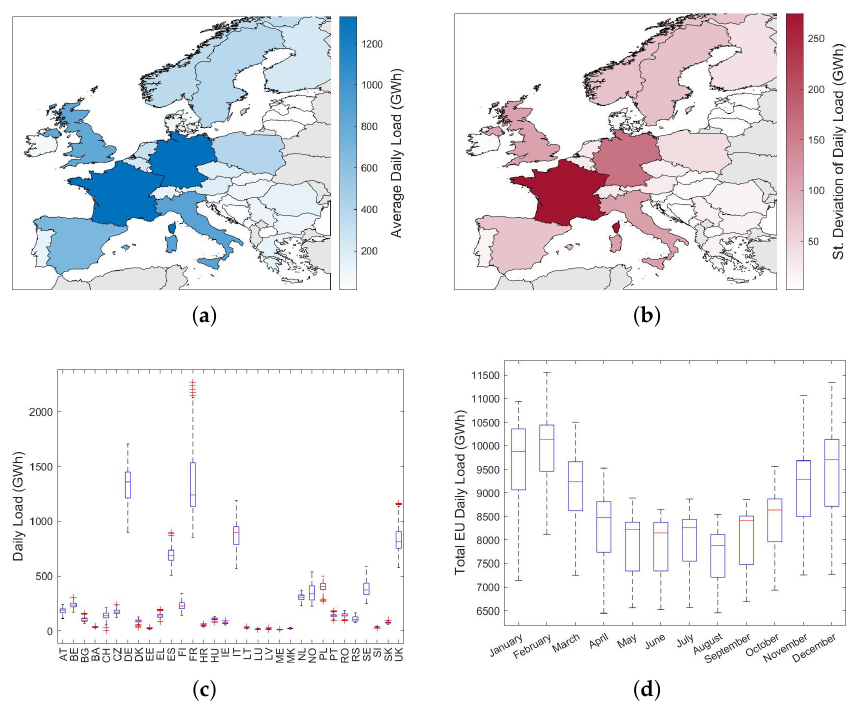
Figure 2. Statistical aspects of load sample data: shown are the country average ( a ), standard deviation ( b ), unconditional distribution ( c ) and a seasonal analysis of the aggregate load ( d